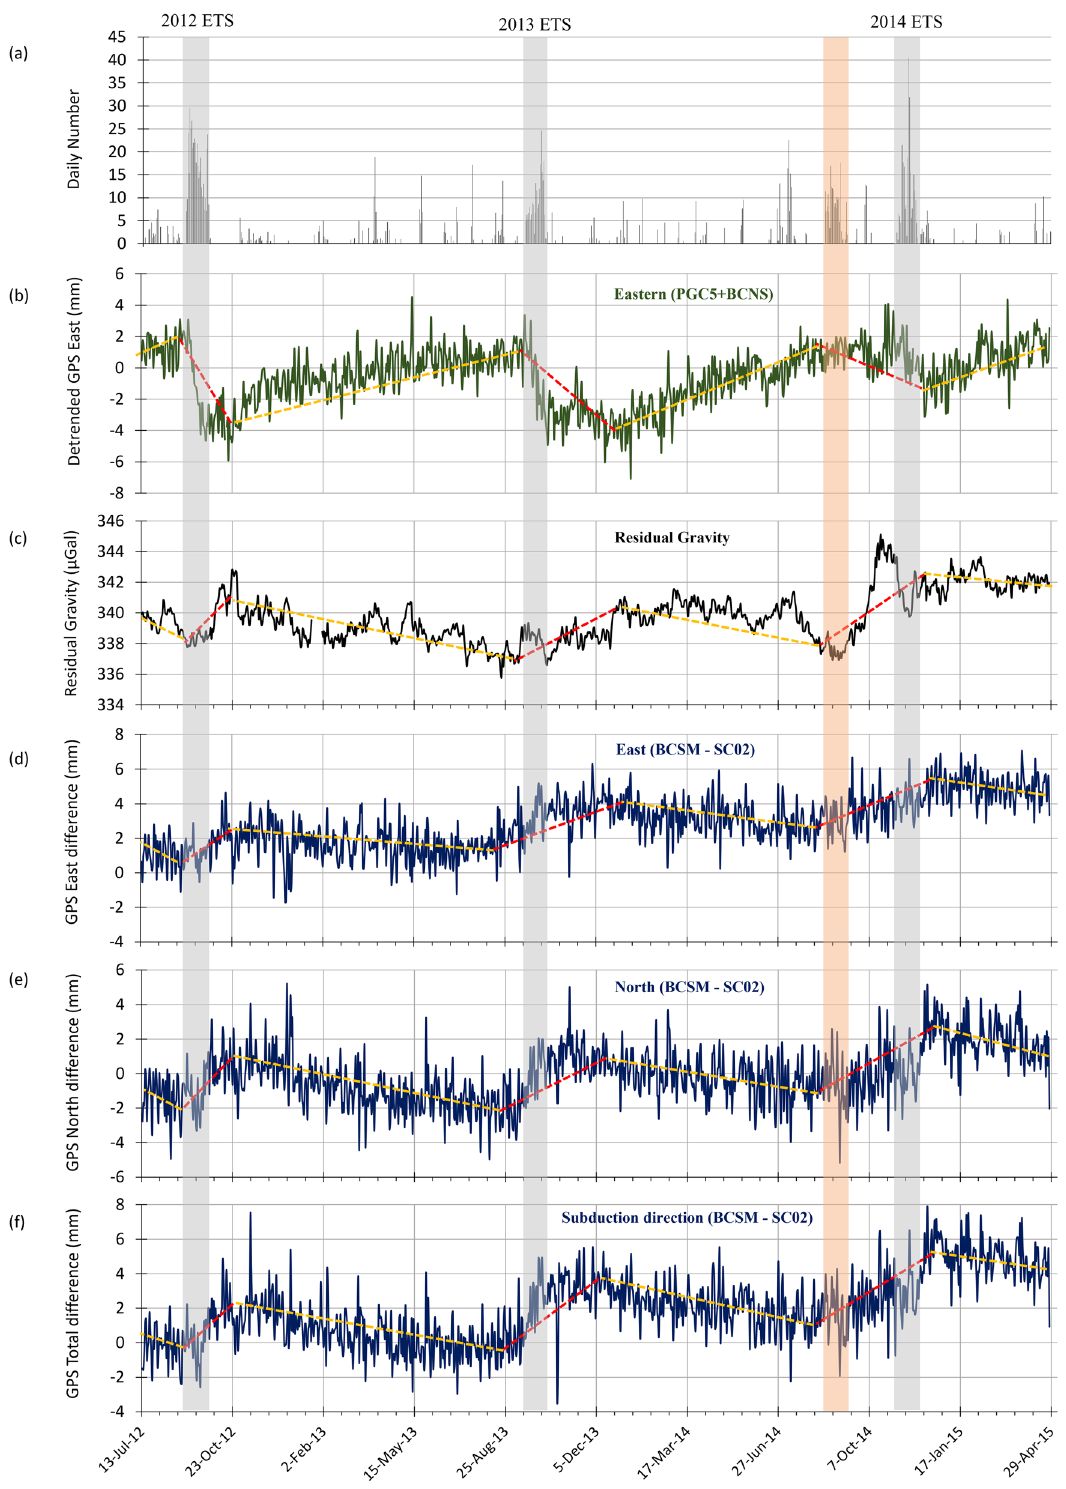
Fig. 6 Comparison of residual gravity with relative movement of GPS stations. a Daily number of ETS events; ( b ) Detrended eastern movement with red dashed lines indicating periods with westerly GPS trends and yellow dashed lines displaying periods with easterly GPS trends; and ( c ) Residual gravity with red dashed lines indicating periods with increasing gravity and yellow dashed lines displaying periods with decreasing gravity trends; ( d ) Relative eastern and ( e ) relative northern movement of BCSM GPS station with respect to SC02 station; ( f ) Relative movement of BCSM GPS station with respect to SC02 station in the direction of subduction. The three main ETS events occur in the gray time-period columns and a fourth period with high tremor activity is detected and shown with an orange